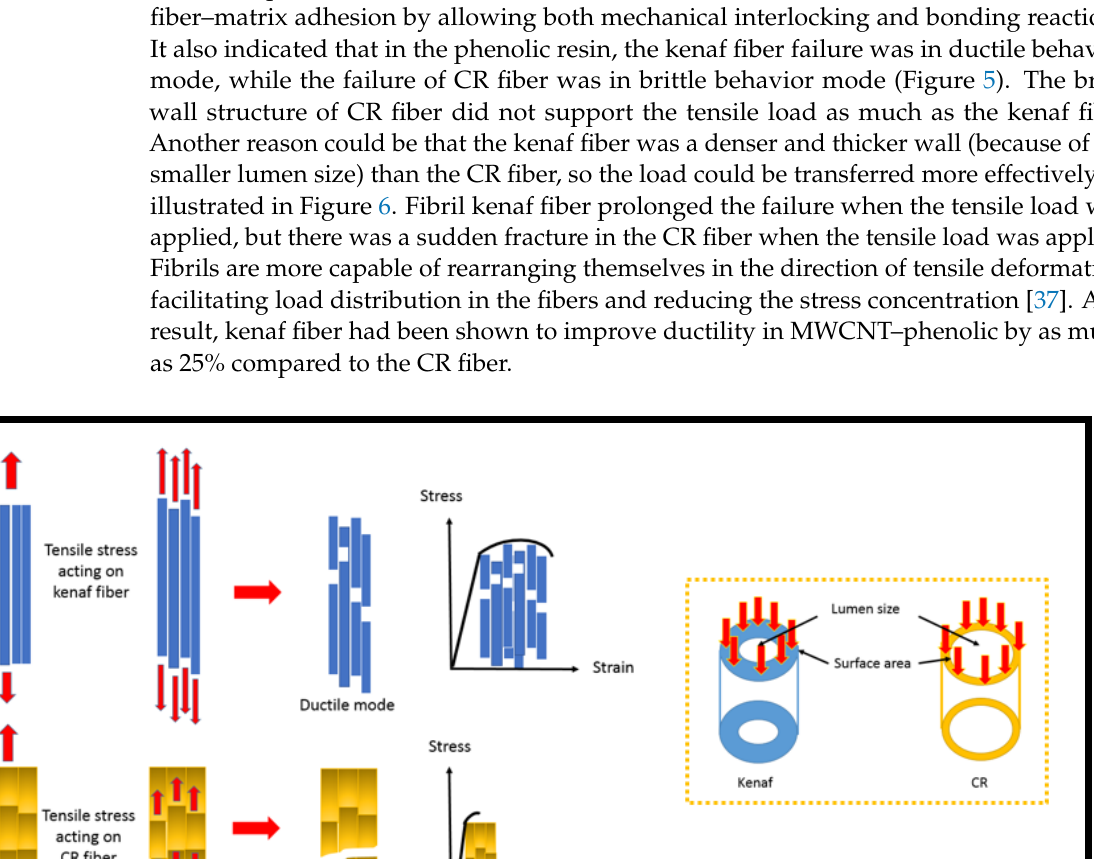
Figure 6. Schematic illustration of tensile fracture on CR and kenaf fiber.